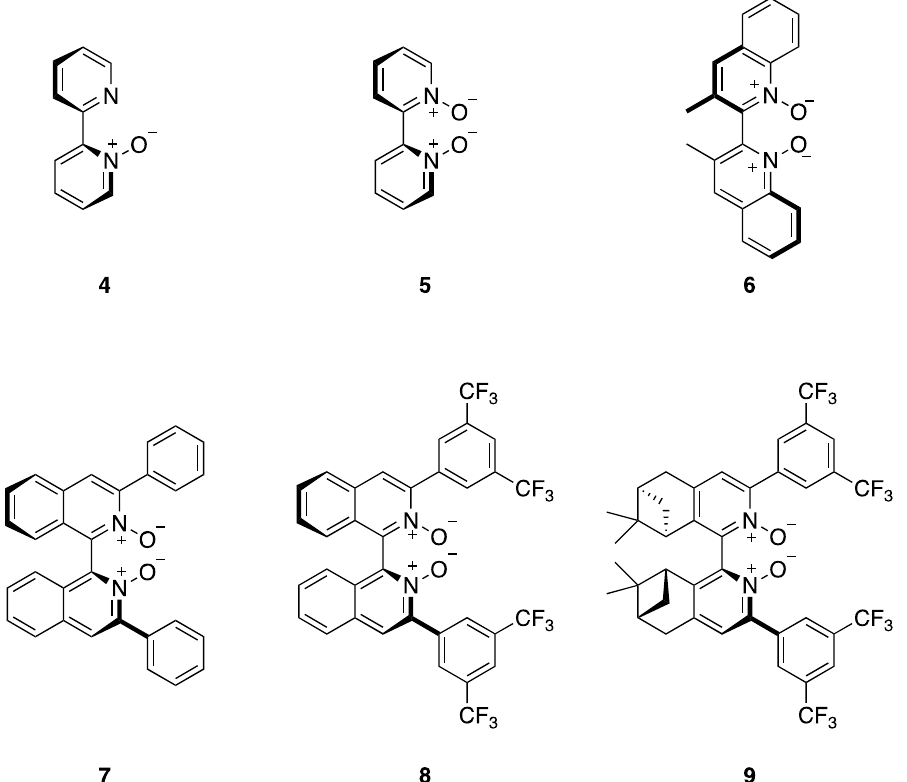
Figure 2. Structures of the catalysts that have been computationally characterized in the literature ( 4 – 7 , 9 ) as well as Takenaka’s catalyst studied in this work ( 8 ). Structures 5 – 9 are C 2 -symmetric ; see also the label of Figure 1 and Section S2 of the Supporting Information for additional visual repre- sentations.